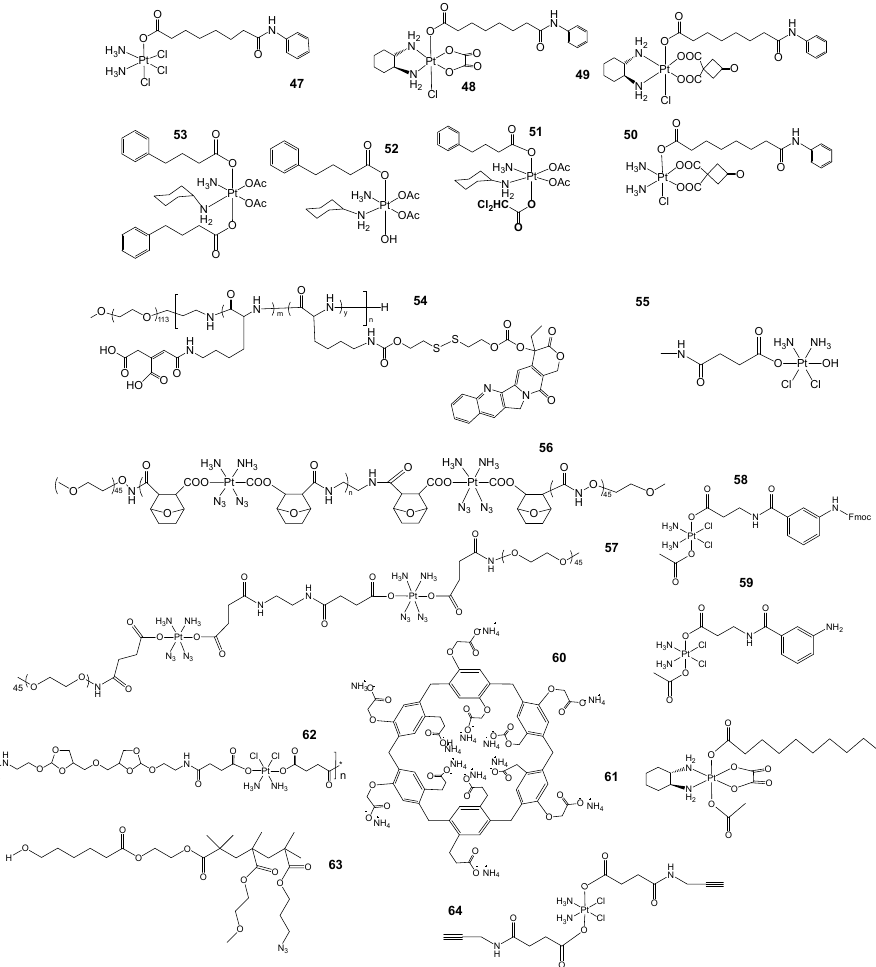
Figure 9. Structures of complexes with DNA expression/histone post-translation related depres- sants. ( 47, 48 , 49 , 50 ) Pt(IV) prodrug structure containing HDACi. ( 51 , 52 , 53 ) Three satraplatin analogs designed by Dan Gibson’s group. ( 54 , 55 ) A prodrug for the simultaneous activation of Pt as well as the redox polymer of camptothecin. ( 55 , 56 ) Structures of DDNPs ( 55 ) and SNNPs ( 56 ). ( 57 , 58 ) Two Pt(IV) prodrugs containing PARPi3-aminobenzamide (3-ABA) fragments. ( 59 , 60 ) The supramolecular combination chemotherapy system (DOX@PtC10-CP6A) was prepared from CP6A ( 59 ) and Pt(IV) to obtain an amphiphilic aggregate (PtC10-CP6A) ( 60 ) which was then wrapped in DOX. ( 61 ) Octahedral coordination of Pt(IV) predrugs. ( 63 , 64 ) Components of dual drug co-deliv- ery systems. Reprinted with permission from Ref. [89-93,97,101-103].